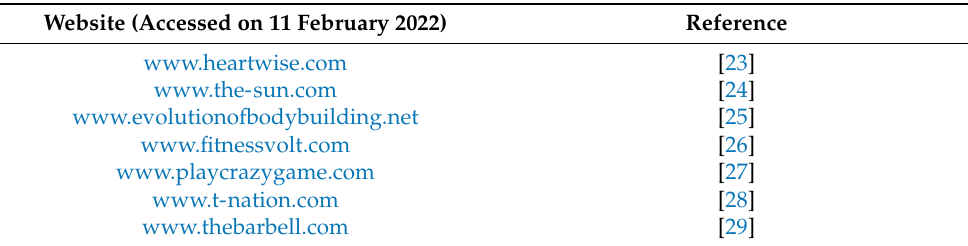
Table 1. Search results for dead